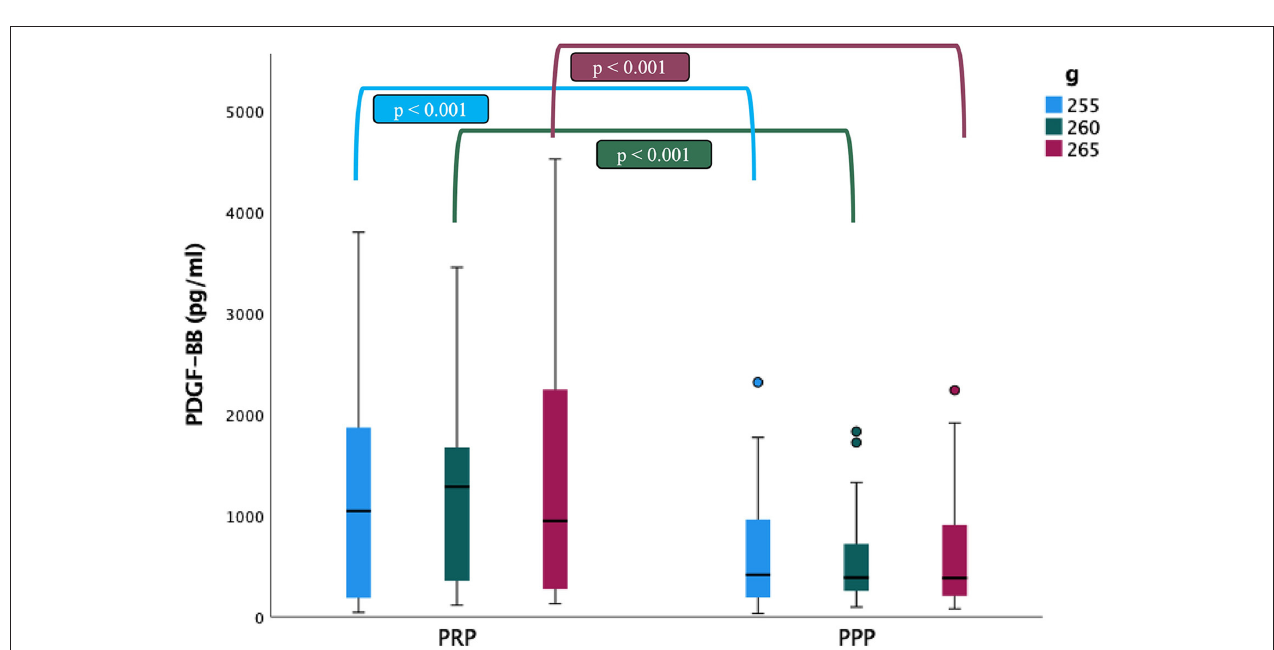
FIGURE 2 | Comparison of the platelet (PLT) concentrations (mean ± SD) in cat ( n = 30) between whole blood (WB), PRP and PPP fractions according to the three centrifugation protocols (g: 255, 260 and 265 in 10min; NC: non-centrifugate). • : Outlyers data included in the statistically study.